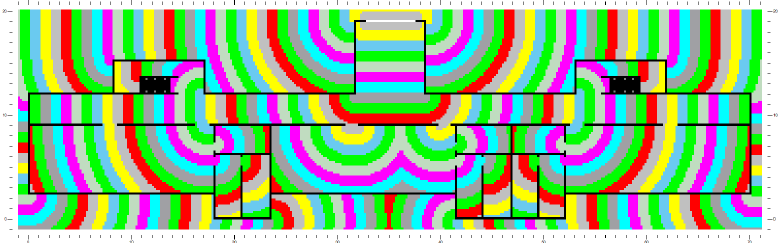
Figure 5. The distance map. Table 4. Parameter settings of the simulation model.